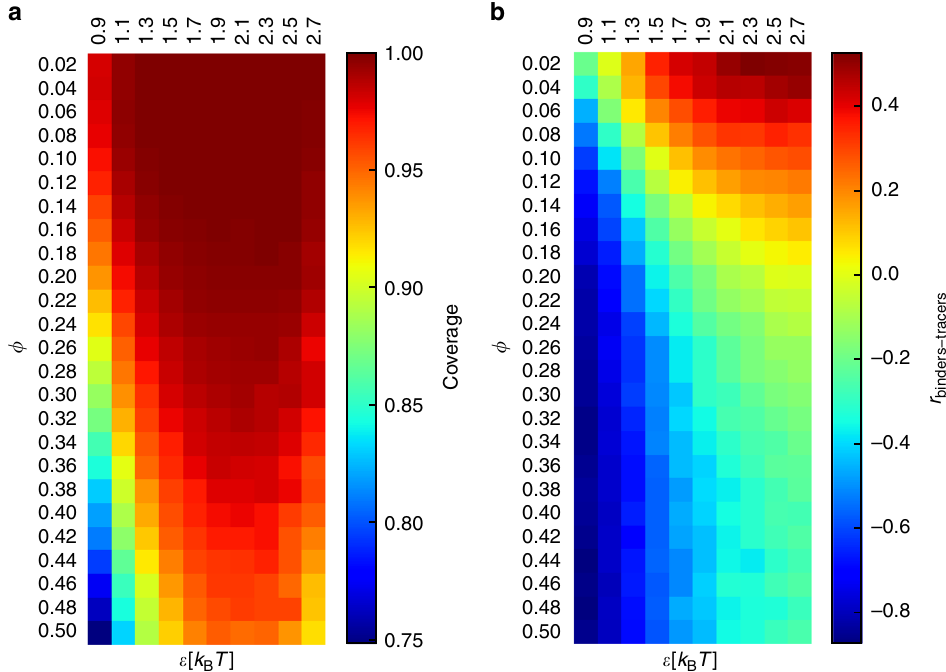
Fig. 4 Volume exclusion effects in the simulations. a Average percentage of sites of the polymer that are visited by the tracers during the simulations (coverage). b Average values of the Pearson correlation between the tracer and binder occupancy